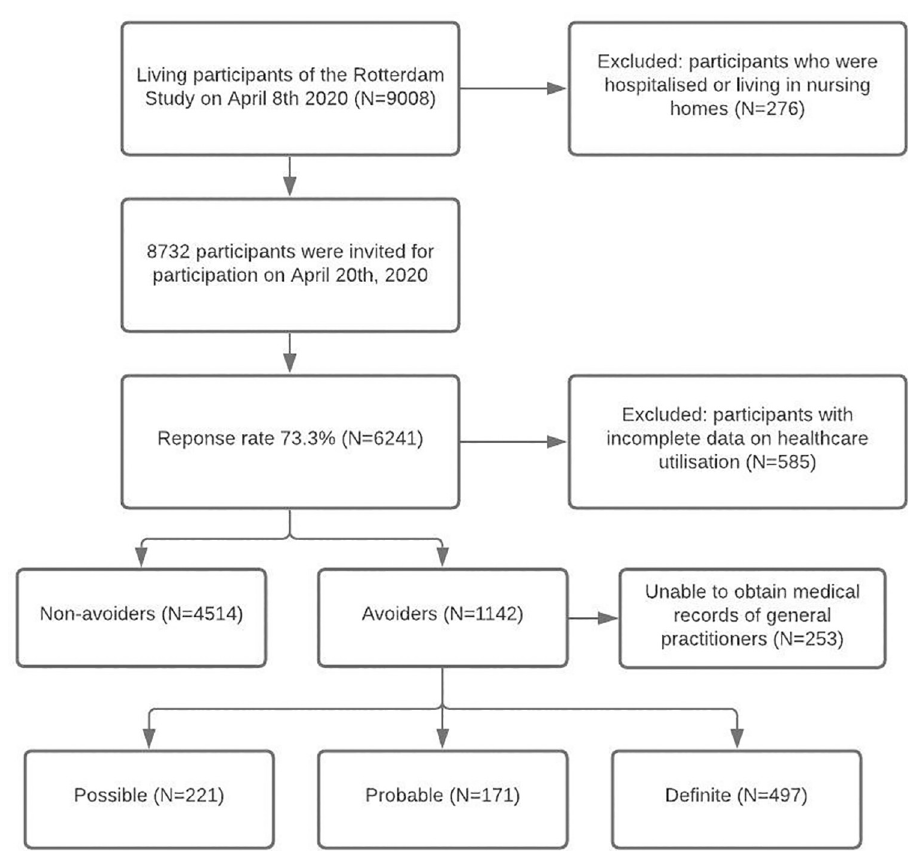
Fig 1. Flow chart of the study population. N , number of